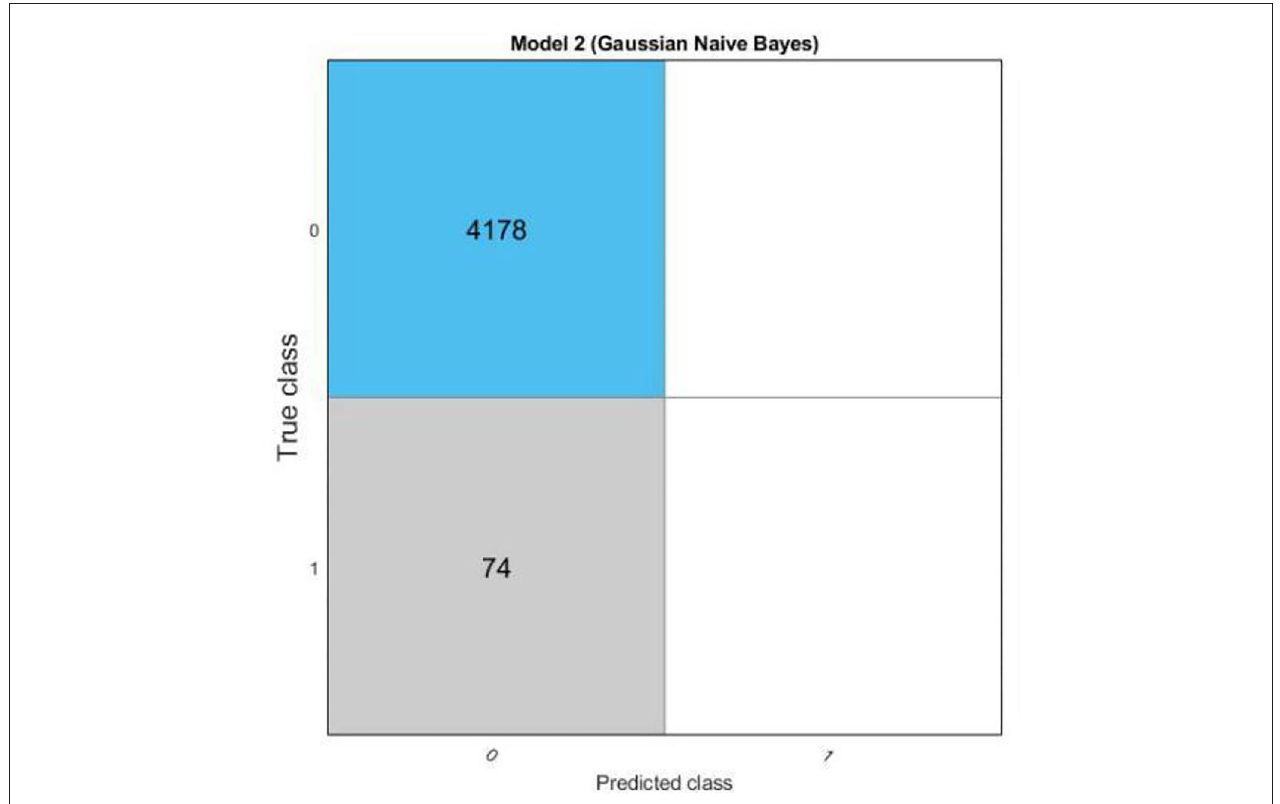
FIGURE 11 | Confusion matrix plot with true class and predicted class from logistic regression.